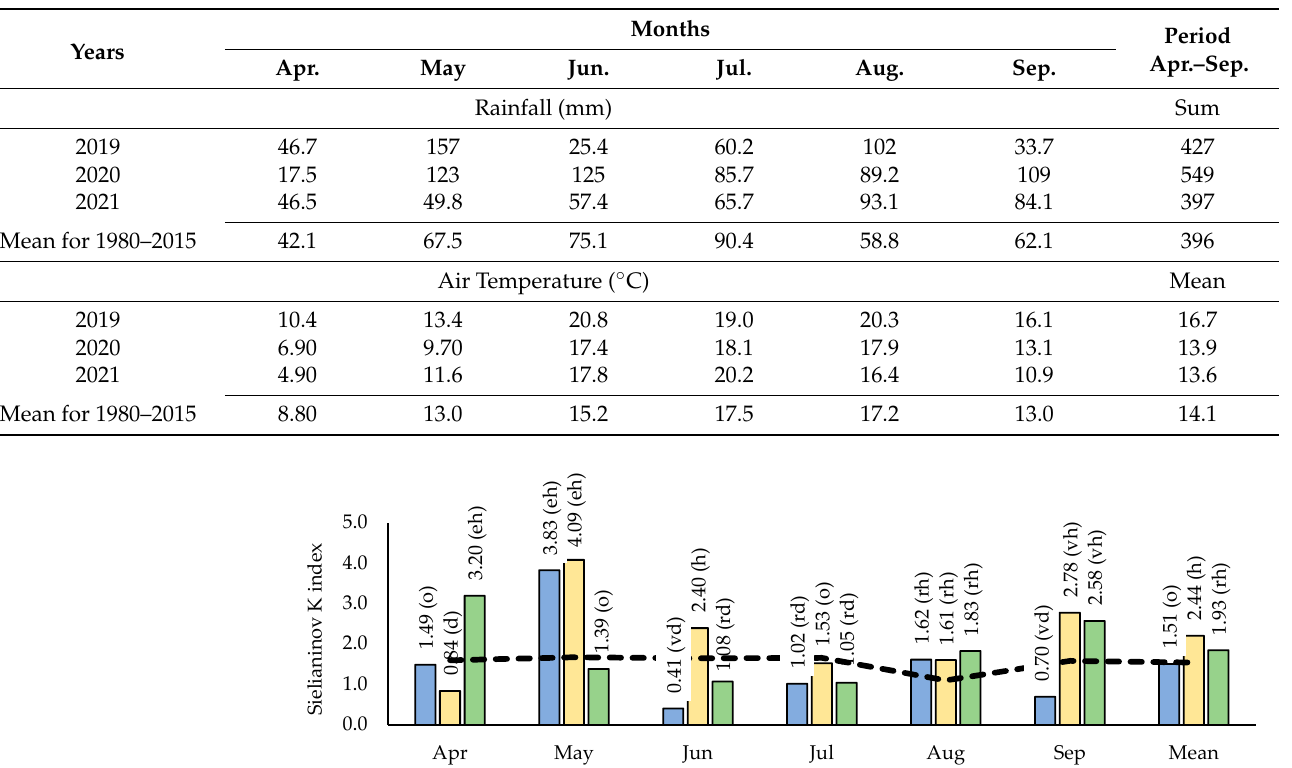
Table 2. Course of weather conditions during potato growing season (2019–2021).